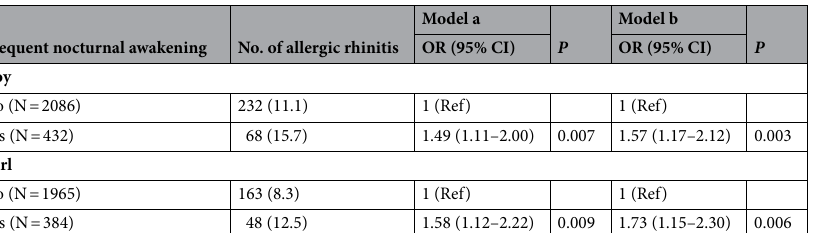
Frequent nocturnal awakening No. of allergic